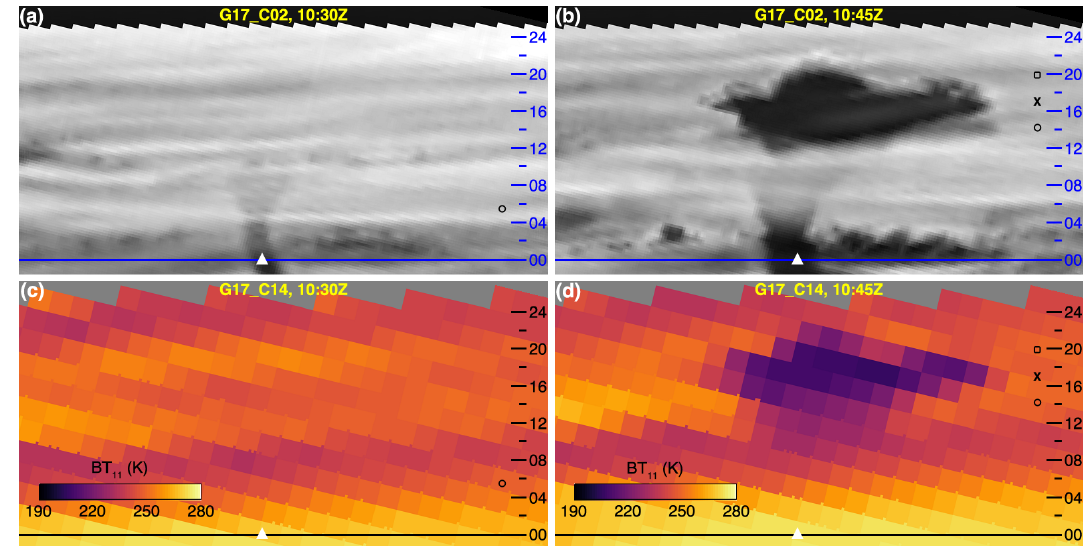
Figure 12. The eruption plume on 13 April 2021 at (a, c) 10:30UTC and (b, d) 10:45UTC in GOES-17 imagery: (a, b) channel 2 and (c, d) channel 14, with elevation markings as in Fig.